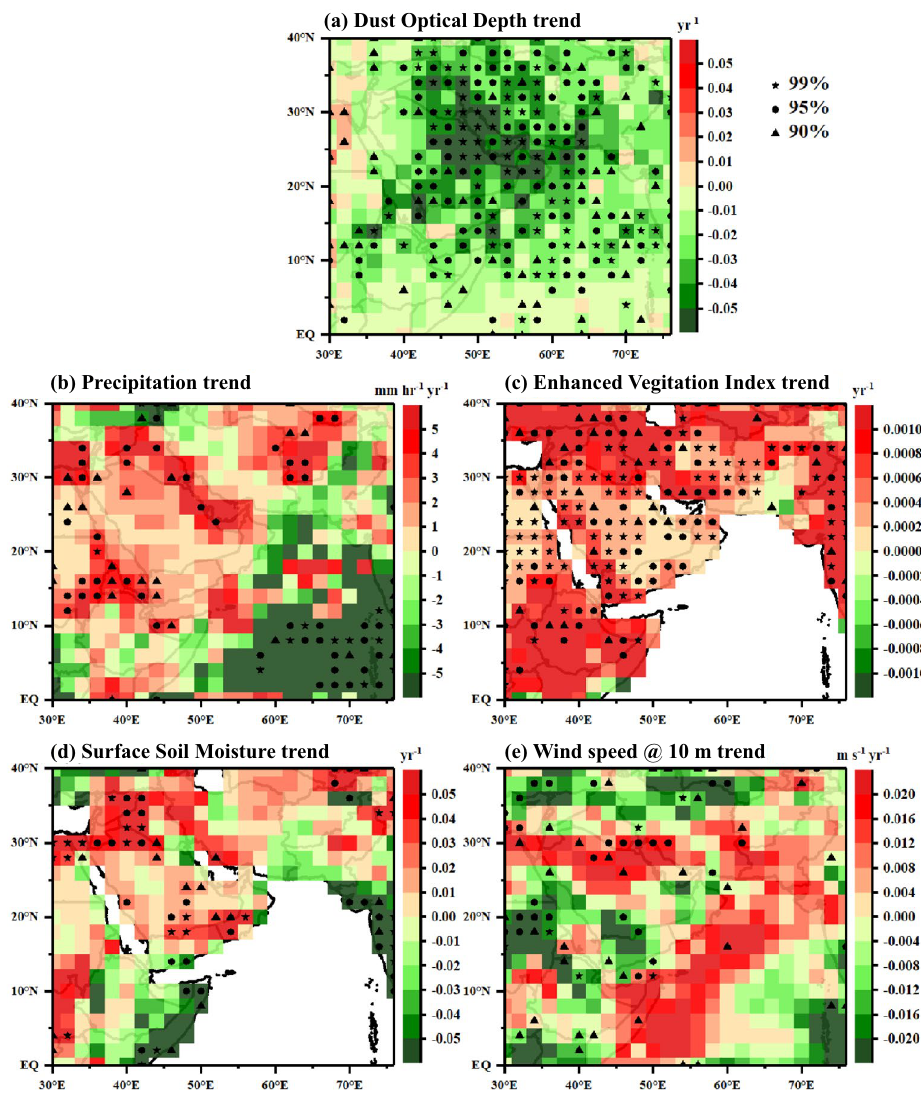
Figure 3. The annual trends in (a) dust optical depth (DOD from CALIPSO), (b) precipitation (PPT; from GPM), (c) enhanced vegetation index (EVI; from Aqua-MODIS C6), (d) surface soil moisture (SSM; from MERRA-2), and (e) wind speed (WS 10 ; from MERRA-2) in JJA during 2007 to 2020 at each 2° × 2° cell over the study region. The trend is estimated using the linear regression, and the statistical significance is ensured with the Mann–Kendall test, and trends with a confident interval of 99% are shown as star, 95% as filled circle and 90% as filled